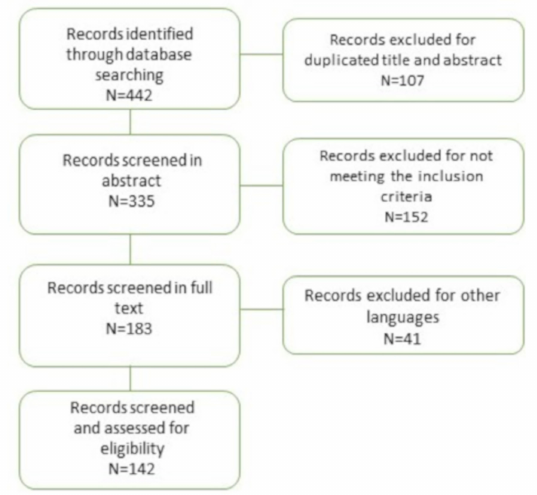
Figure 1. flow chart showing articles selection process.